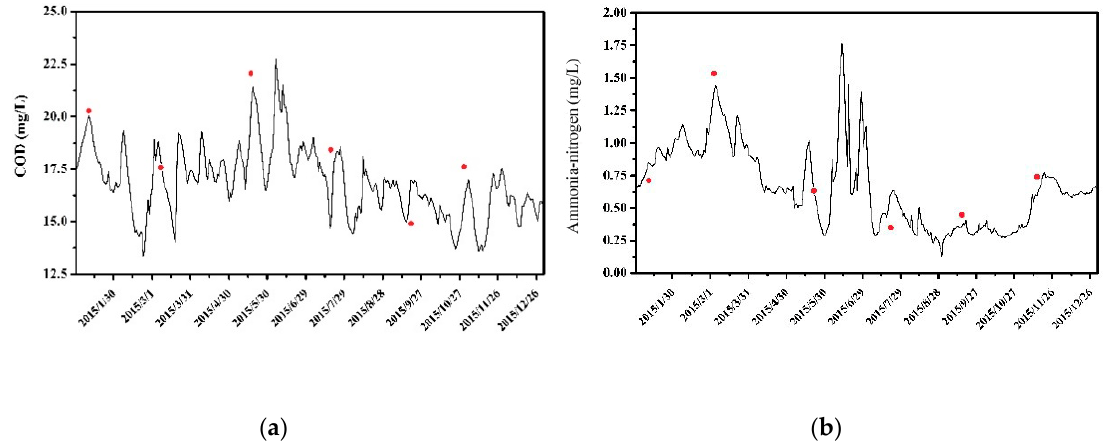
Figure 3. The water quality verification results for ( a ) COD; and ( b ) ammonia nitrogen.